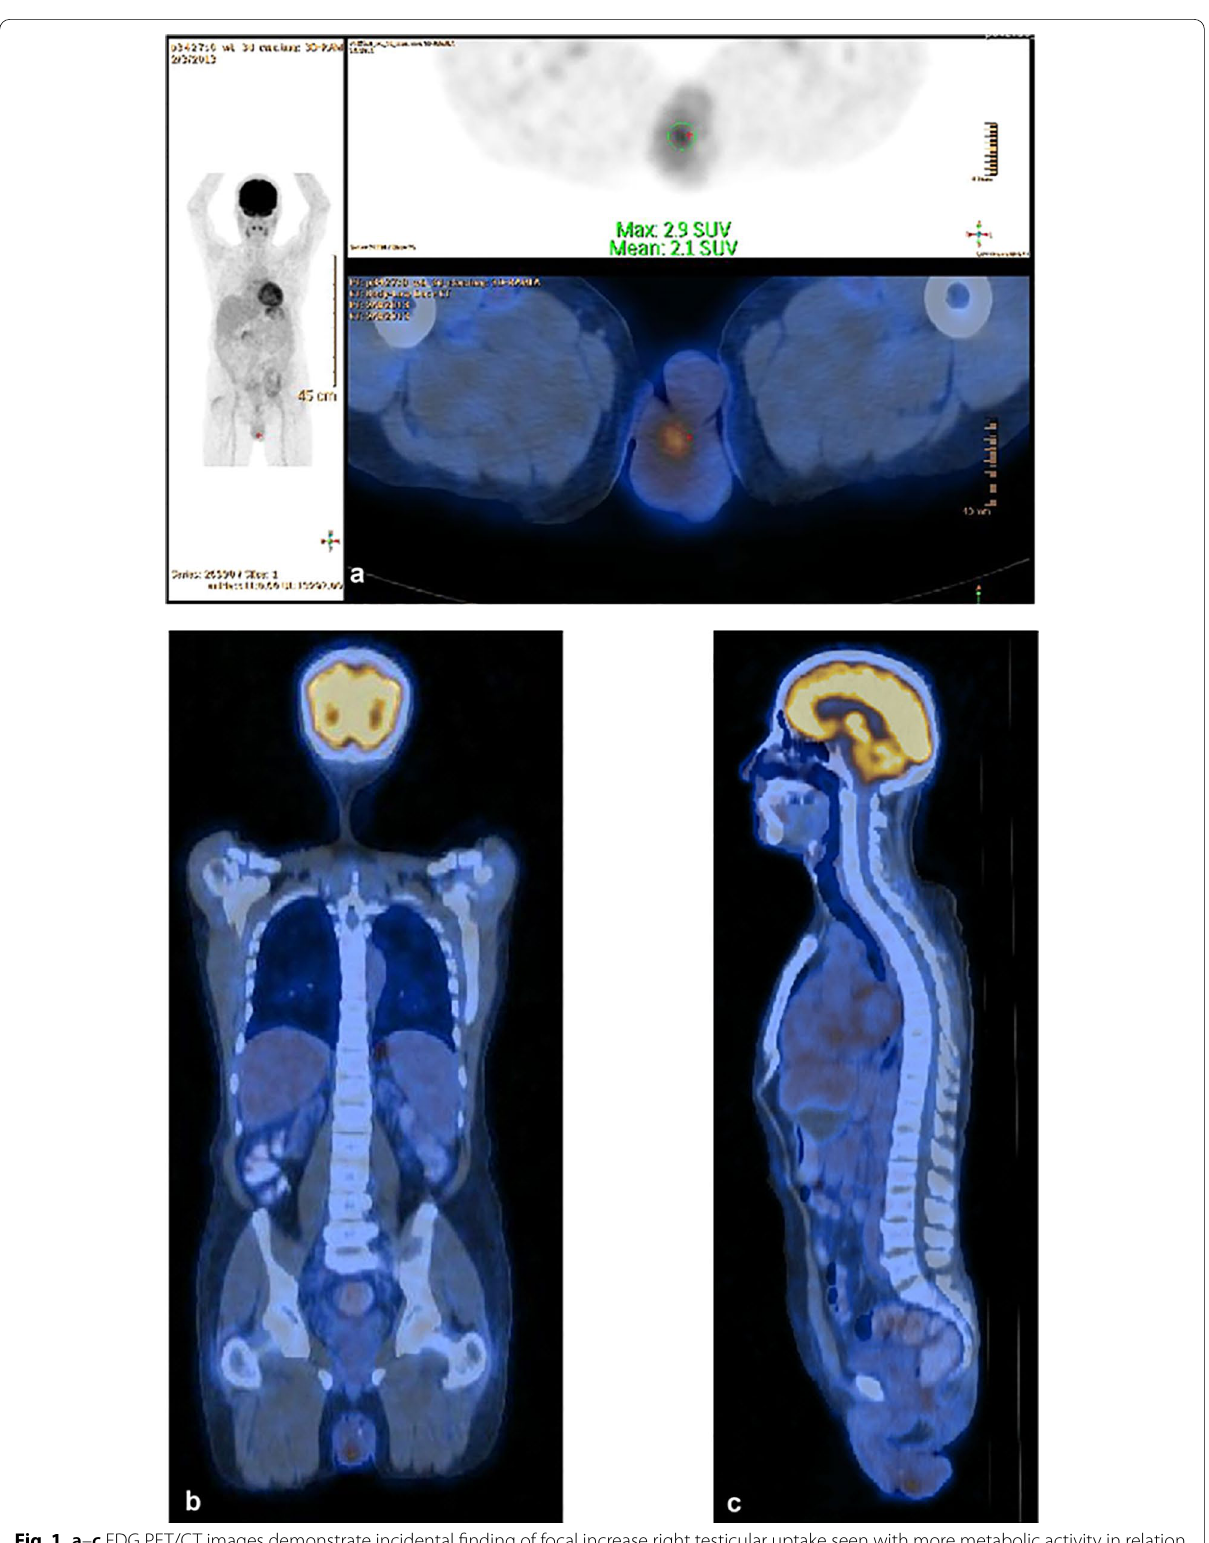
Fig. 1 a – c FDG PET/CT images demonstrate incidental finding of focal increase right testicular uptake seen with more metabolic activity in relation to the remaining testicular tissues (SUV max 2.9). No specific findings in other areas or definitive FDG avid